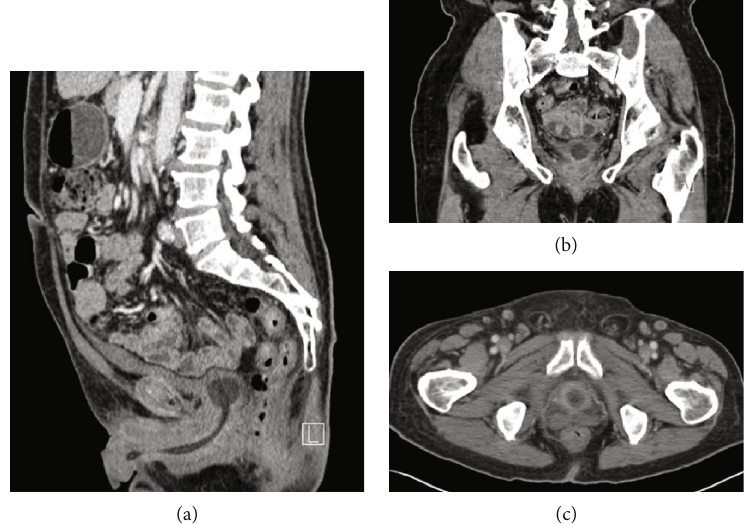
Figure 2: CT of the pelvis: (a) sagittal, (b) coronal, and (c) axial views of the prostate showing near resolution of the abscess with minimal residual fl uid seen in the left posterior aspect at the base of the prostate.